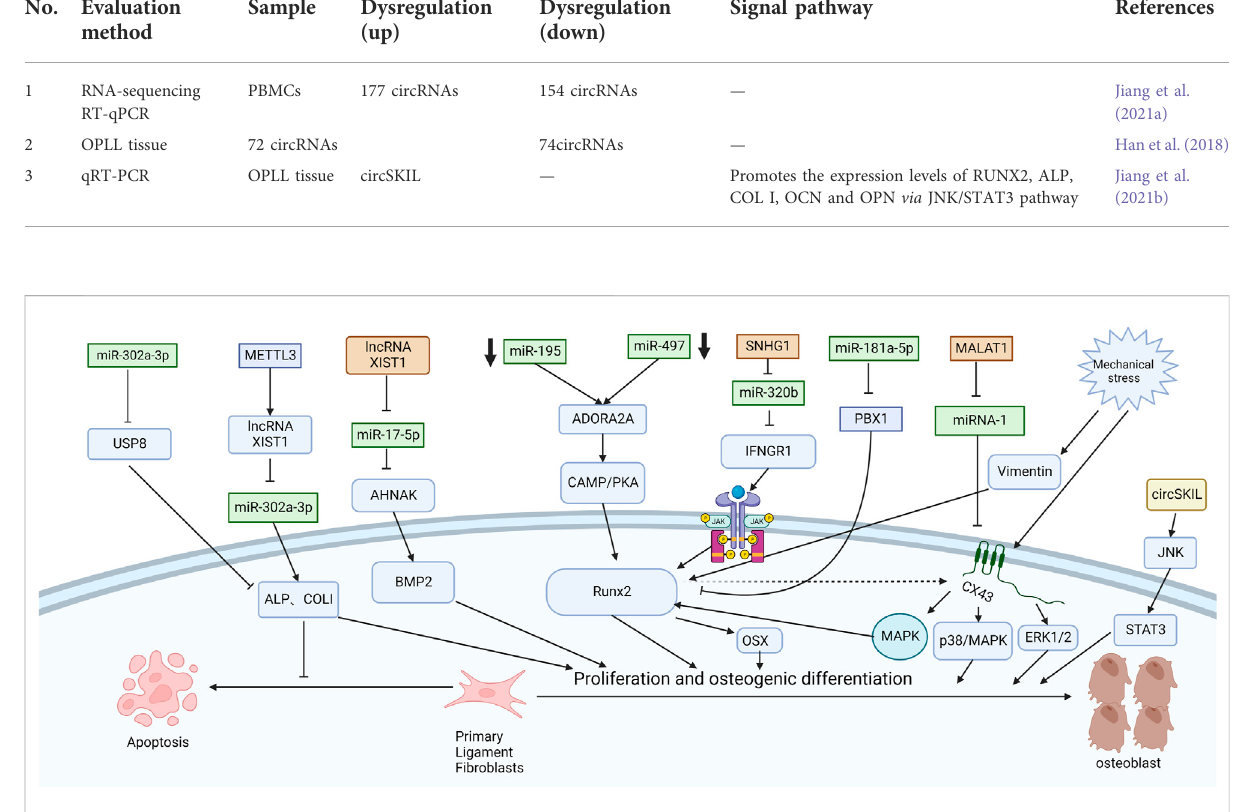
FIGURE 2 Functions of speci fi c ncRNAs in ligament fi broblasts. ( “ Created with BioRender.com ”